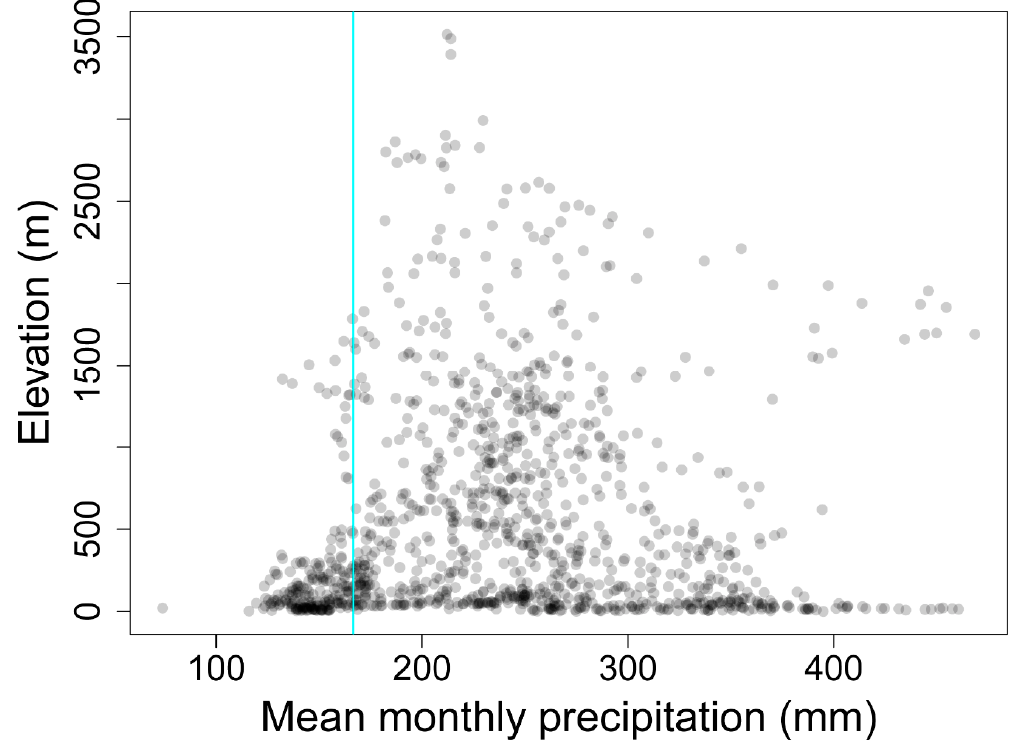
Figure A3. Scatterplot of precipitation and elevation values at reference data locations across Costa Rica. Darker colors indicate higher densities of points, and the blue vertical line indicates precipitation of 2000 mm annually (~167 mm on average per month), the Holdridge threshold for the low-elevation dry forest